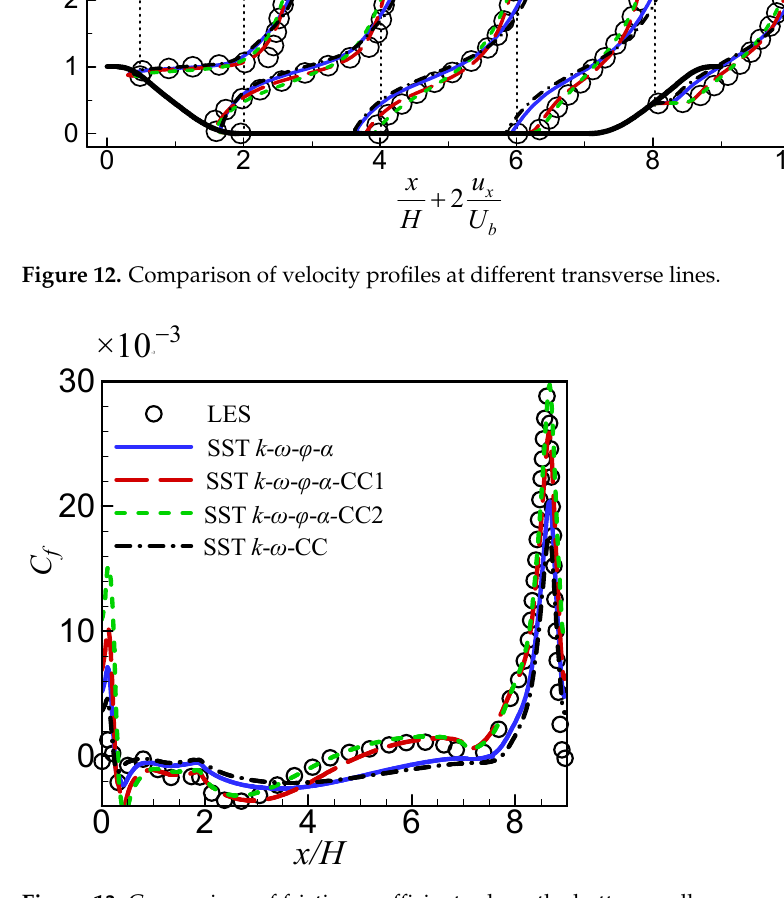
Figure 13. Comparison of friction coefficients along the bottom wall. Table 2. The separation point (Sep.), re-attachment point (Reatt.), and the re-circulation length (Len.), in the 2D periodic hill flow.